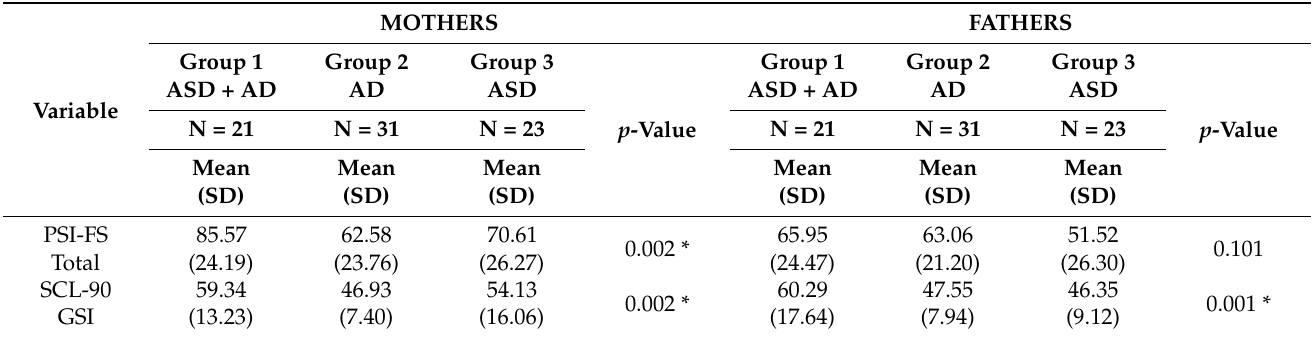
Table 4. Comparison between the three groups in parent assessment scores separately for mothers and